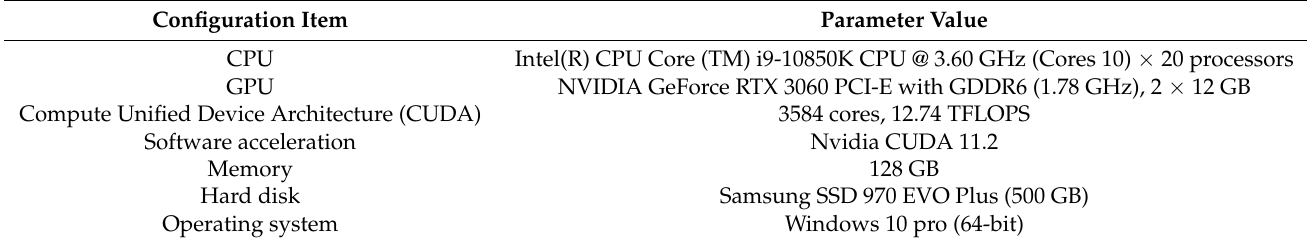
Table 6. Configuration